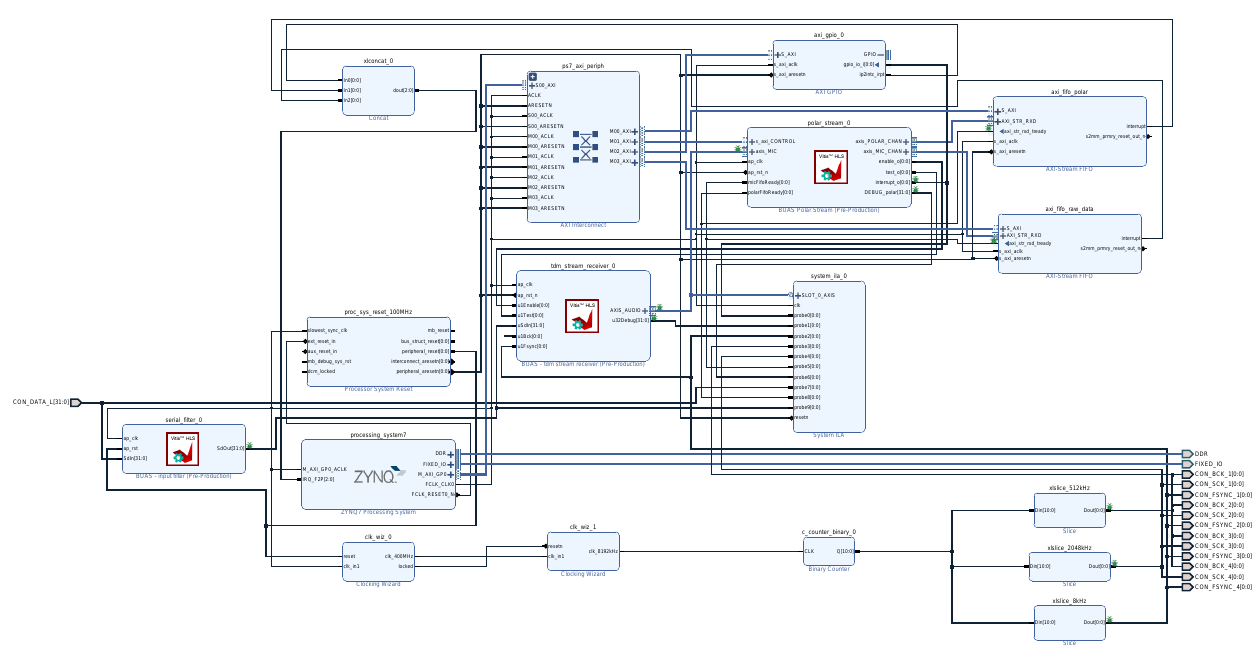
Figure 6. PL implementation in Xilinx Vivado Design Suite